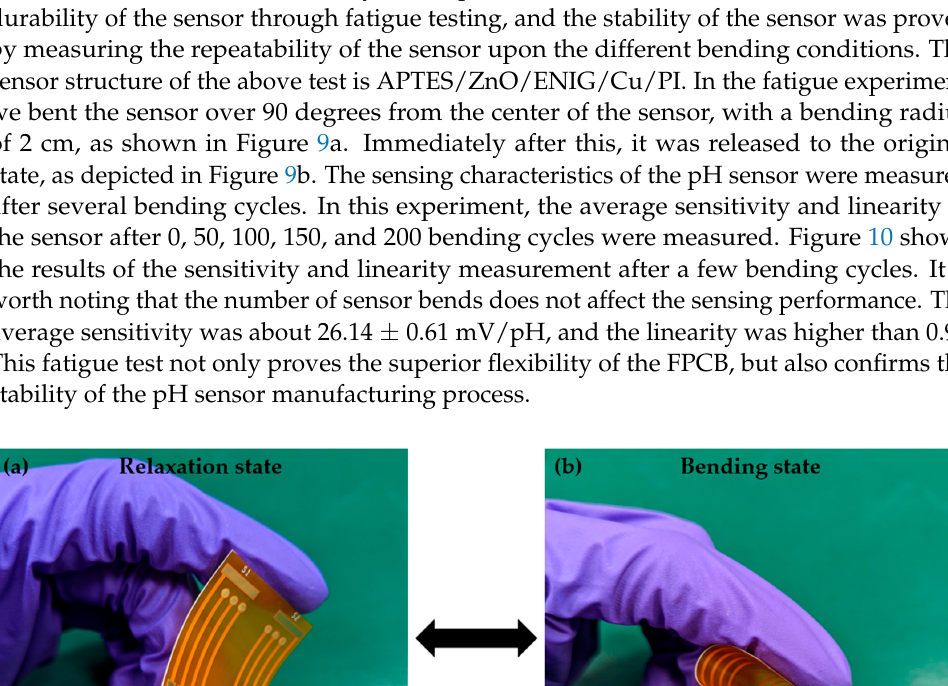
Figure 8. The repeatability of the pH sensors based on ZnO and AZO films.